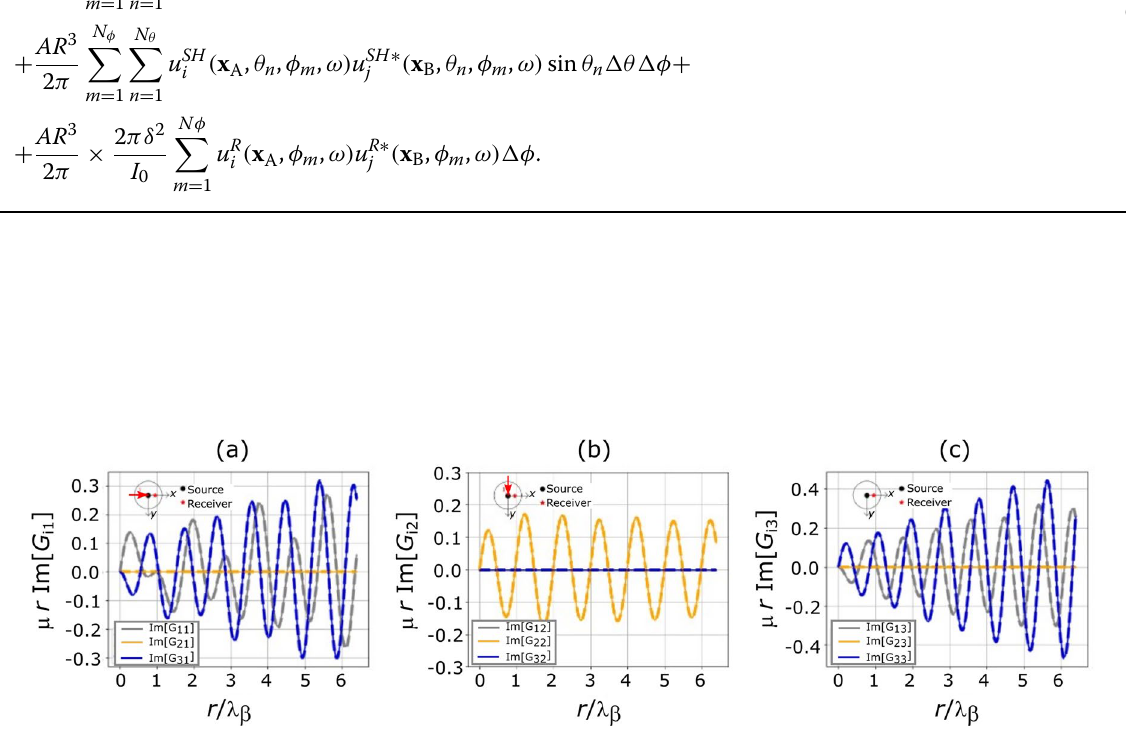
Fig. 2 Comparison of imaginary part of the Green functions for the case of source and receivers at the surface of an elastic Poissonian half‑space. The source is at the origin (0, 0, 0) T and the receivers are located along x ‑axis at ( r , 0, 0) T , where r EQP are depicted with discontinuous lines while the continuous lines correspond to DWN. Results display the non‑dimensional Green’s function G ij components µ r Im against the normalized distance r / (cid:31) β , where (cid:31) β [ ] while the third one to G i3 Lamb’s. Gray, yellow and blue lines represent motion in x , y and z directions,